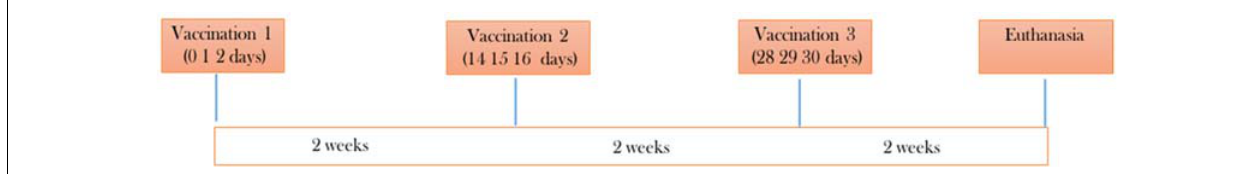
FIGURE 1 | Protocol of immunization: For vaccination study mice were vaccinated three times at 2 weeks interval. On day 42 from the start of immunization, all animals were euthanized.